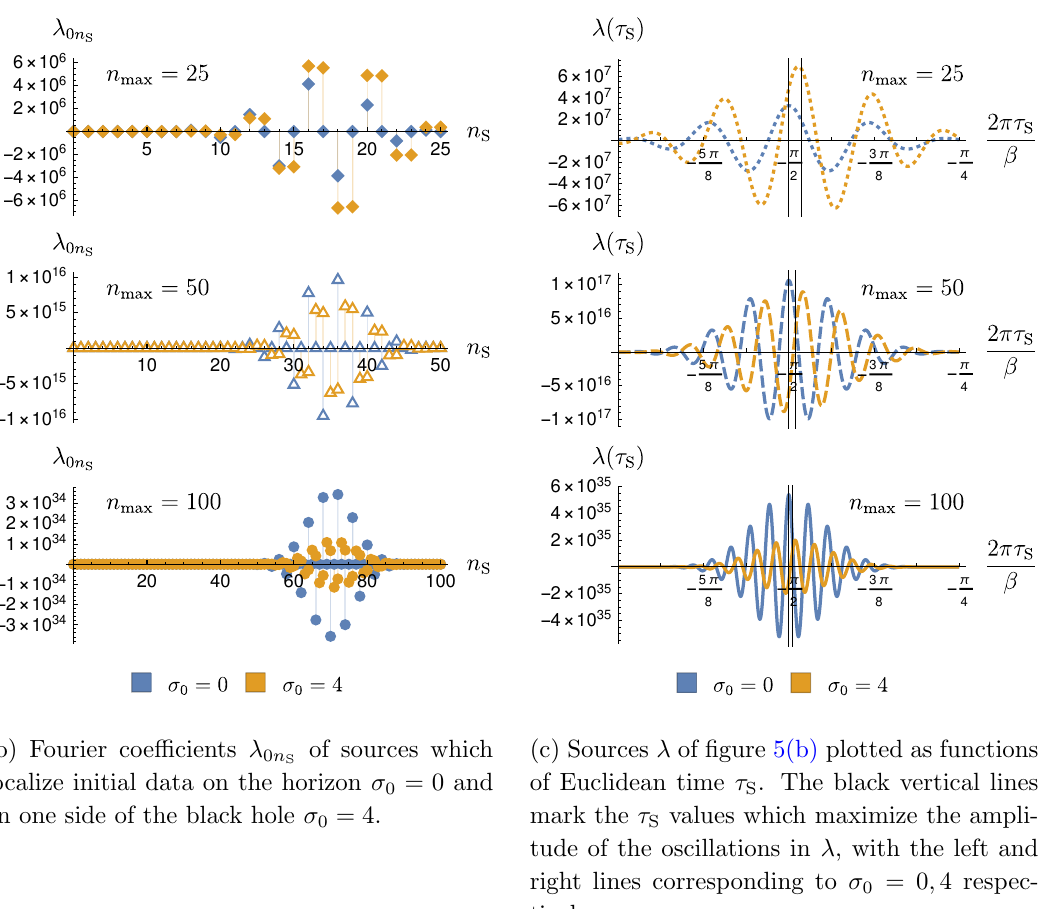
(a) Localized initial data which minimize the variance V [Φ] about σ 0 = 1, plotted for UV cutoffs n max = 25 , 50 , 100 on the sources.